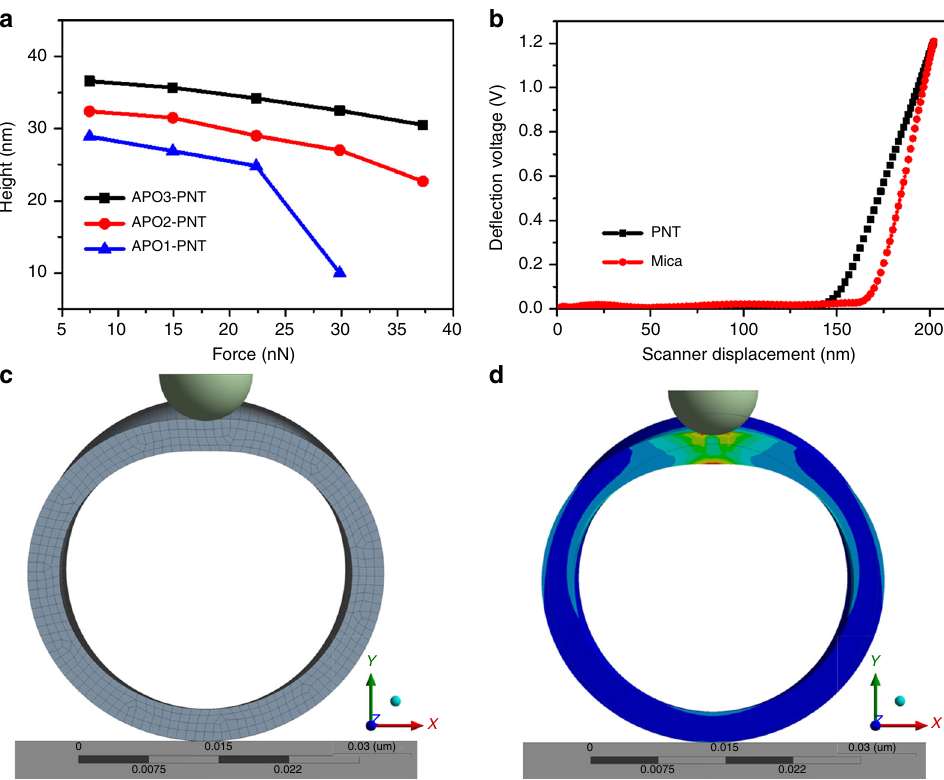
Fig. 5 Mechanical properties of PNTs. a Height vs. force curves. For all experiments, the same silicon nitride cantilever ( k = 0.4 N/m) was used. All force measurements were performed in an AFM fl uid cell with deionized water. b A representative force vs. displacement curves. Before tapping the PNTs surface, the de fl ection voltage was around 0 (horizontal segment). After contacting with PNT ’ s surface, the de fl ection voltage increased gradually (slope segment). c , d FEM simulation for indentation of a PNT. The curvature radius of the indenter was set at 5 nm. The length to diameter ratio of the PNT was 10:1. c Before indentation. d After